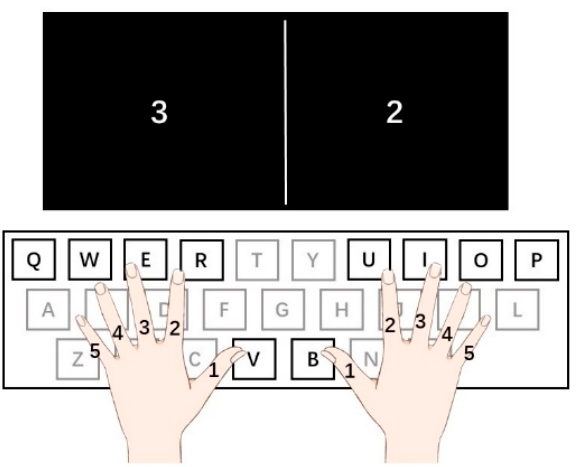
Figure 1. Experimental protocol. During the experiment, participants placed their fingers on the buttons for the left hand: thumb- button V, index finger-button R, middle finger-button E, ring finger-button W, little finger -button Q, and for the right hand: thumb- button B, index finger-button U, middle finger-button I, ring finger-button O, little finger-button P. Two pseudo-random numbers are presented at the two centers of the left and right half screen. The numbers specify each figure for both hands: 1-thumb, 2-index finger, 3-middle finger, 4-ring finger, 5-little finger. For the numbers shown on the left side, they are required to use the left-hand finger specified by the number to press the corresponding buttons, and for numbers shown on the right side, use the right-hand fin- ger.